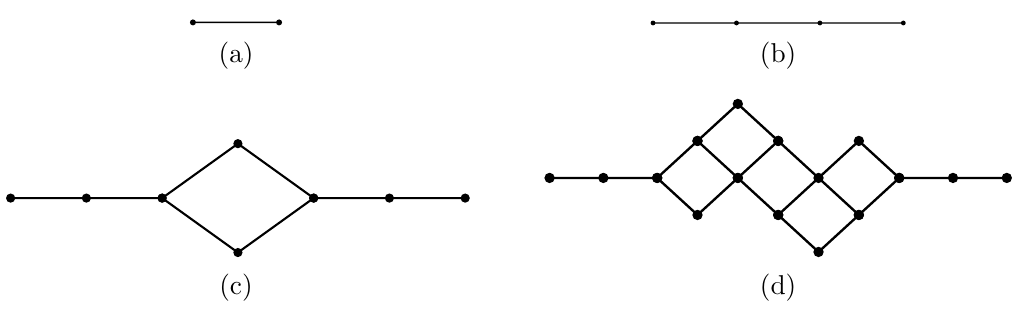
Figure 1 . There is a recurrence of one of the diagrams for each N mod 4. (a) N = 4 m (cid:0) 2, (b) N = 4 m (cid:0) 1, (c) N = 4 m , and (d) N = 4 m + 1, ( m (cid:21) 1)